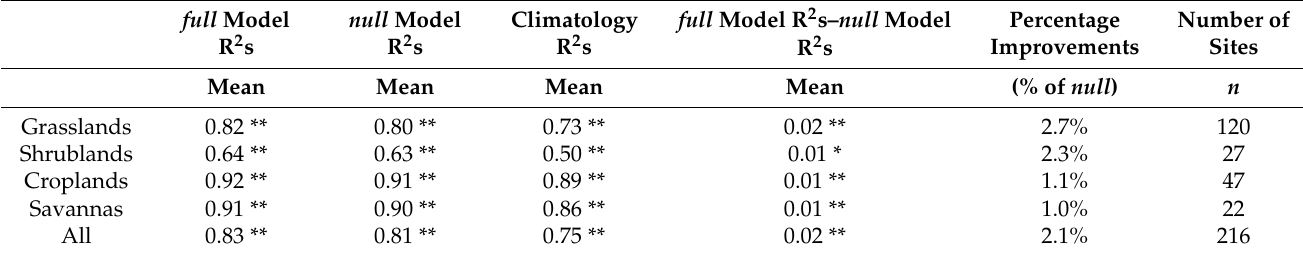
Figure 5. The spatial mapping of difference in R 2 s between the “ full ” models and “ null ” models for the LAI prediction. Table 3. Statistics of “ null ” model R 2 s, “ full ” model R 2 s, R 2 s of LAI climatology for LAI predictions and the statistics of the difference in R 2 s between the “ full ” model and “ null ” model LAI predictions. (asterisks indicate the R 2 s of the models are significantly greater than 0 with different significant levels * 0.05; **